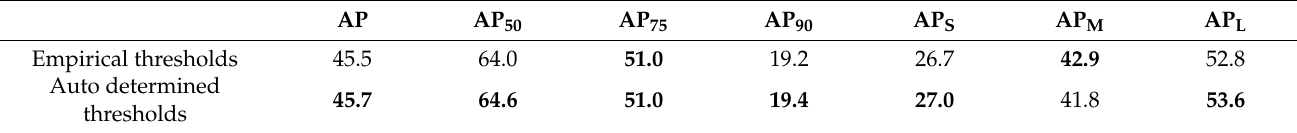
Table 6. Comparison of the detection performance on DOTA-v1.5 dataset, under different IoU threshold settings on the proposed five-stage Cascade R-CNN++, with Resnet-50 backbone.